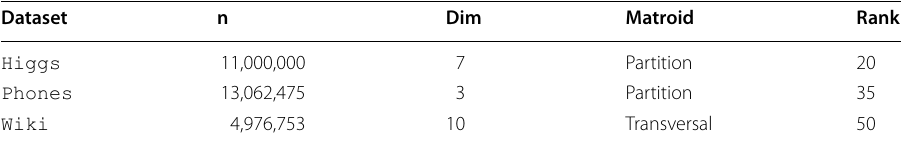
Table 1 Datasets used in this experimental evaluation Dataset